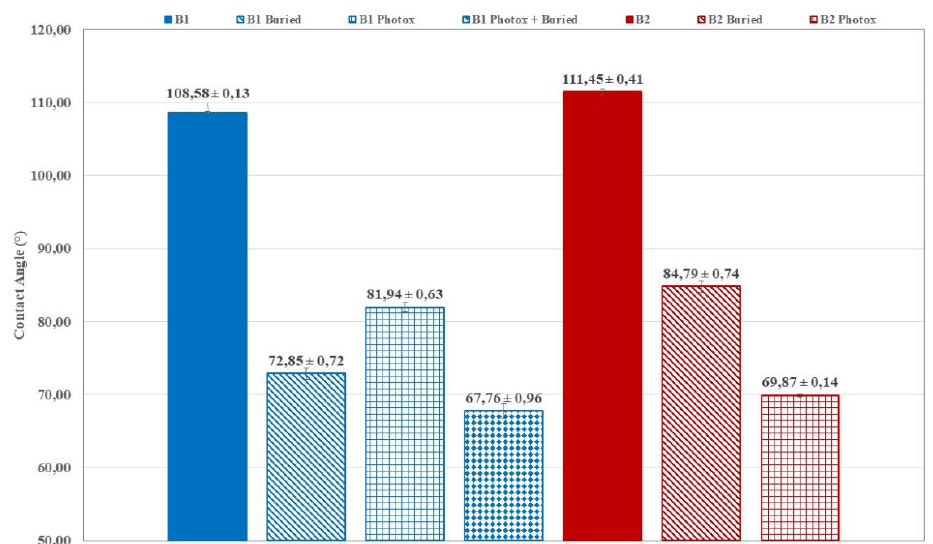
Figure 6. Average contact angle values for the film samples B1 and B2, virgin, buried (125 days) and photo-oxidized. After 125 days of soil burial test, photo-oxidized B2 samples were completely disintegrated and it was not possible to carry out the contact angle (CA) measurements.